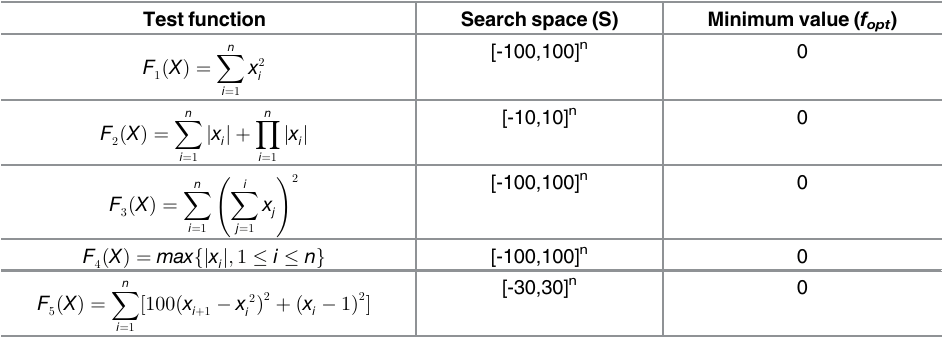
Table 1. Unimodal benchmark functions.